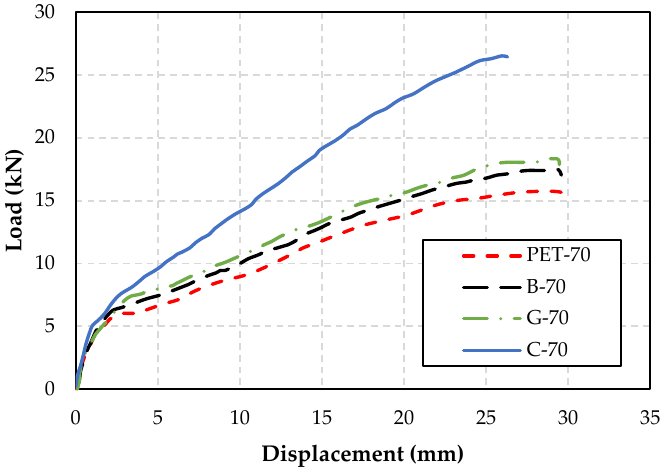
Figure 7. Effect of FRP type on the load-deflection behavior of a strengthened slab specimen.